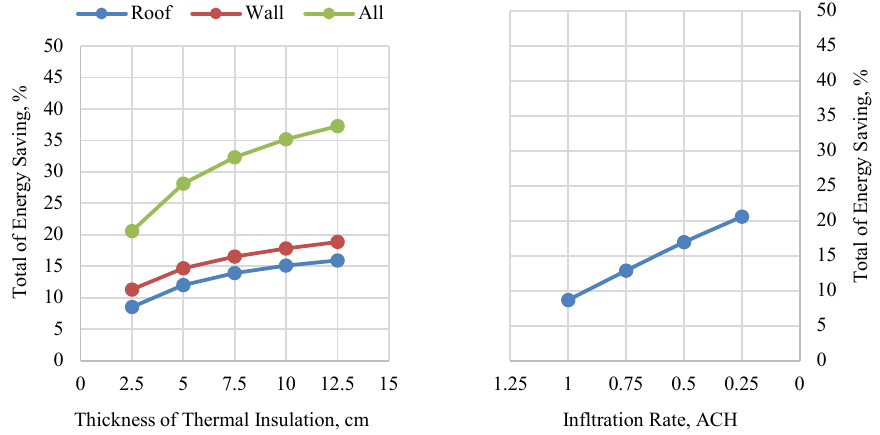
Fig. 6. Annual energy saving present from insulation (left) and infiltration rate (right) in climate zone